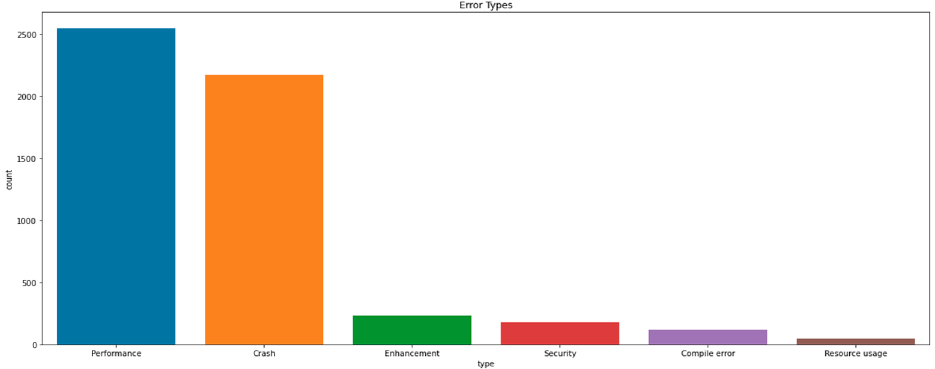
Figure 2. Bar chart of attribute “type”.